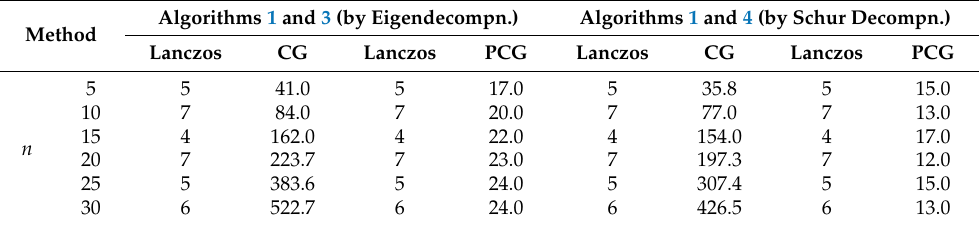
Table A1. Number of iterations of the Lanczos method and the average of numbers of iterations of the CG/PCG method in the case of the 5-th max. singular value of slightly symmetric matrix T with a = c = 1 and b = 0.1 in (9) for the shift (A1).